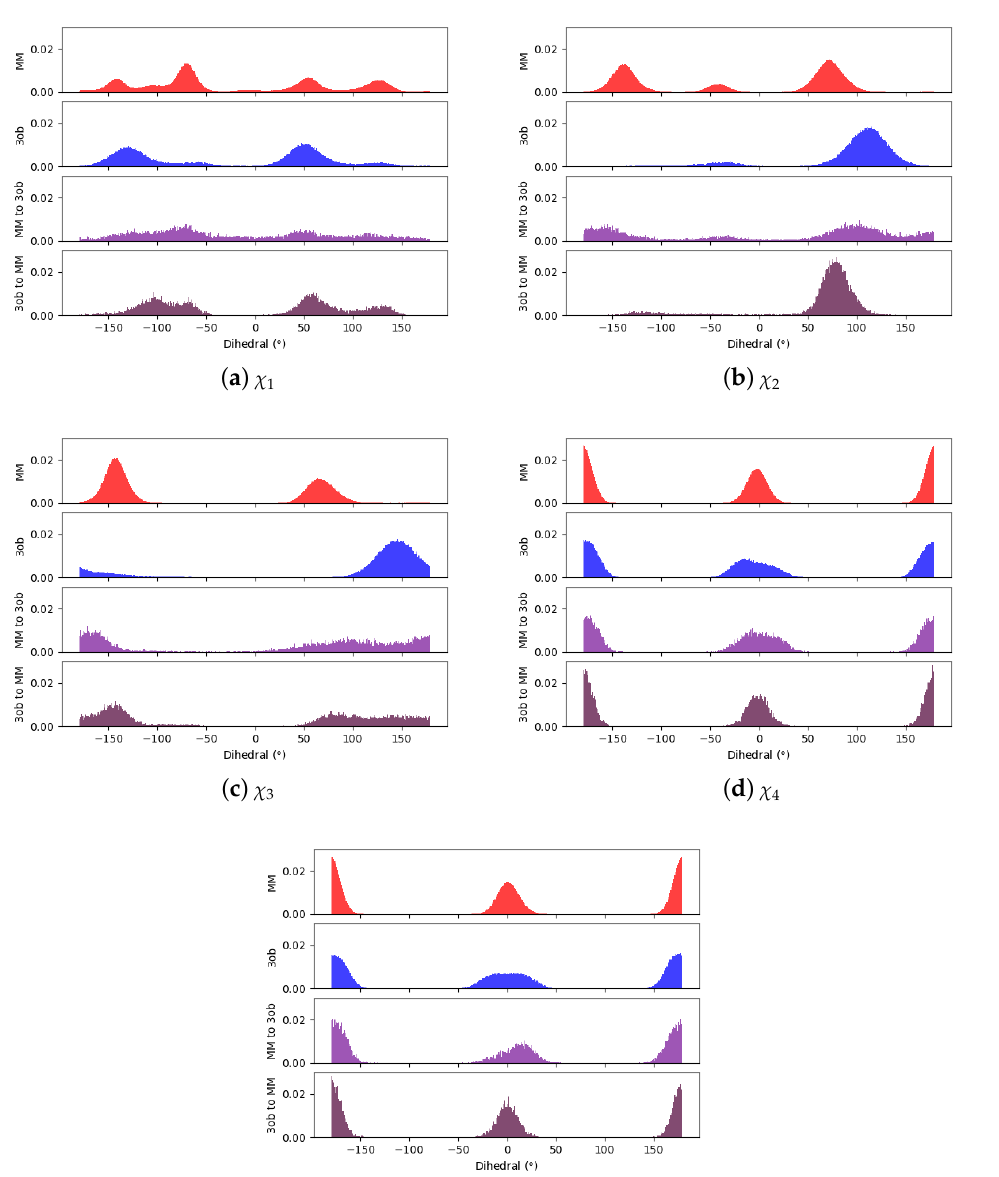
Figure 7. Dihedral populations for 5 ’s dihedral degrees of freedom (see Figure 2 for dihedral labels). Finally, CRO predicts ∆ A MM → 3 ob to be − 537.50 kcal/mol, while FEP(fw) predicts gas − 587.63 kcal/mol and JAR (fw) − 539.16 kcal/mol. The FEP (fw) result is again ≈ 50 kcal/mol from